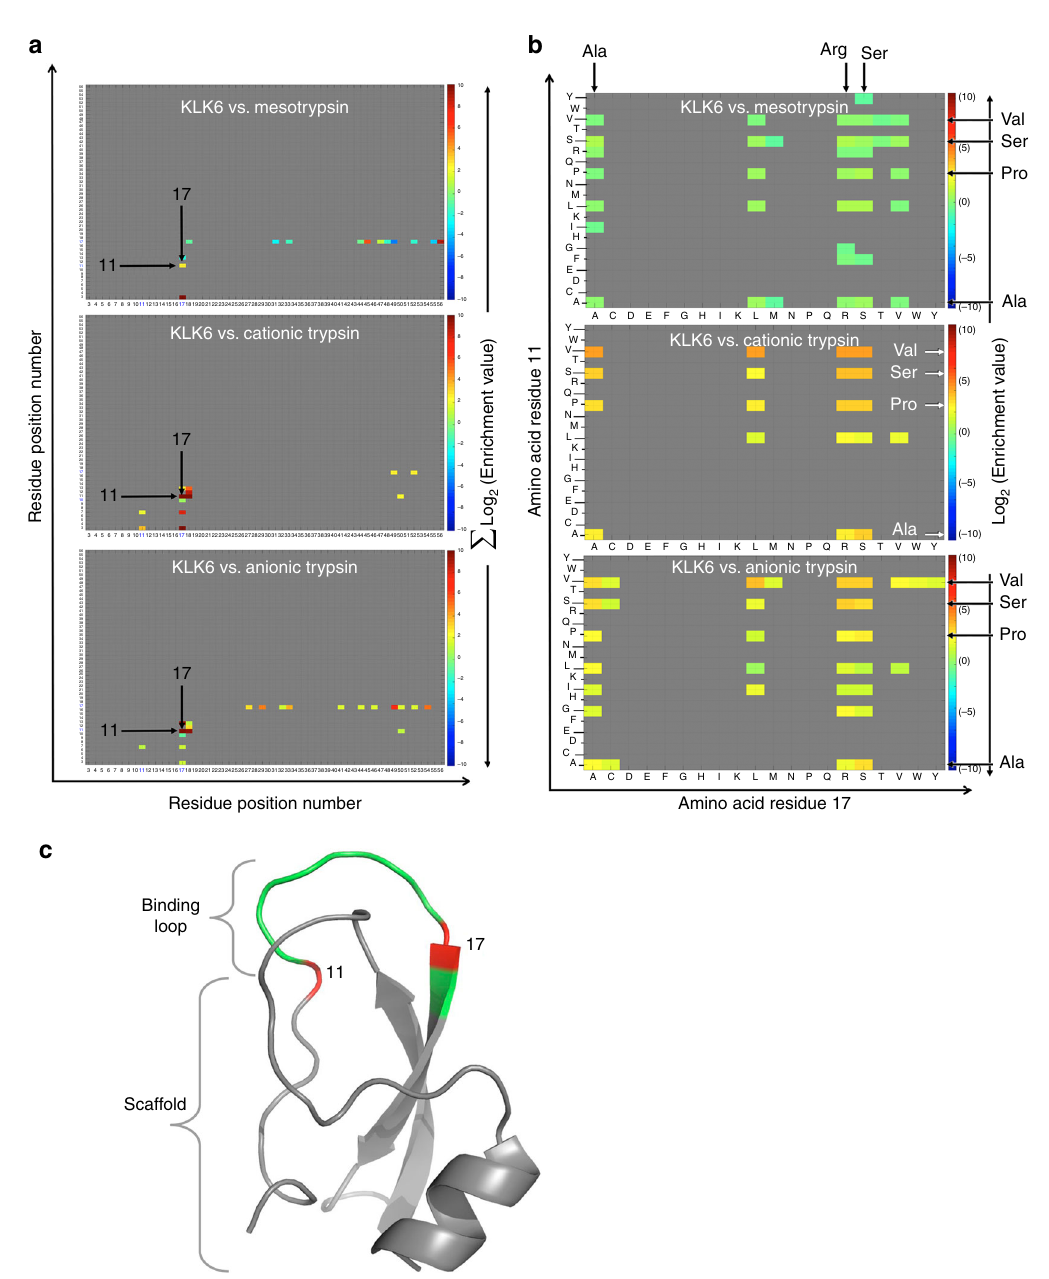
Fig. 3 Double mutation selectivity landscape of APPI-3M. Heatmaps demonstrating the effect of double-amino acid mutations in APPI-3M on the selectivity toward KLK6 versus the three other serine proteases. a The effect of different pairs of mutated residues on selectivity is illustrated by the colors of the heatmaps (red = increased selectivity, enrichment ratio >1; blue = decreased selectivity, enrichment ratio <1). The contribution of each double mutation to selectivity was summed and the maps demonstrate the overall effect. The X and Y axes indicate the position of the substituted amino acid residues. See Supplementary Figure 4 for further details. b The effect of different amino acid mutations at residues 11 and 17 of APPI-3M on its selectivity toward KLK6, illustrated by the colors in the heatmaps. The X axis indicates amino acids mutated at residue 17 and the Y axis indicates amino acids mutated at residue 11. c Crystal structure of APPI-3M (PDB ID: 5C67). Cartoon representation of APPI-3M illustrating the positions of correlated residues Thr-11 and Gly-17 (red) within the APPI binding loop (green, positions 11 – 18). The APPI scaffold is shown in